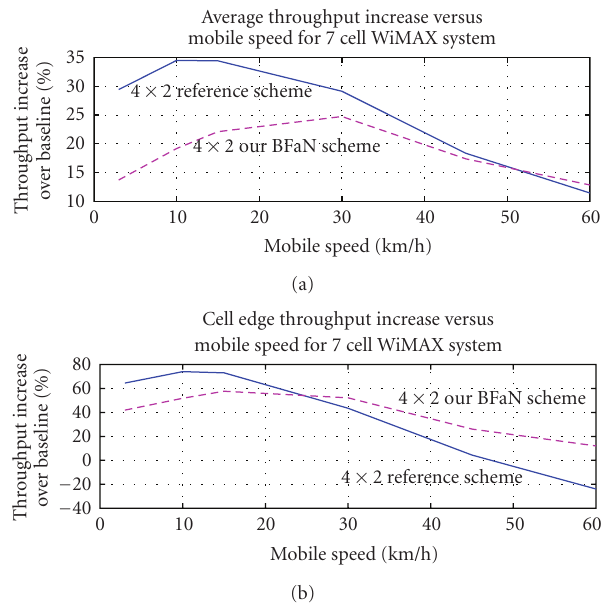
Figure 7: Throughput rate increase of BFaN over the baseline system with moving